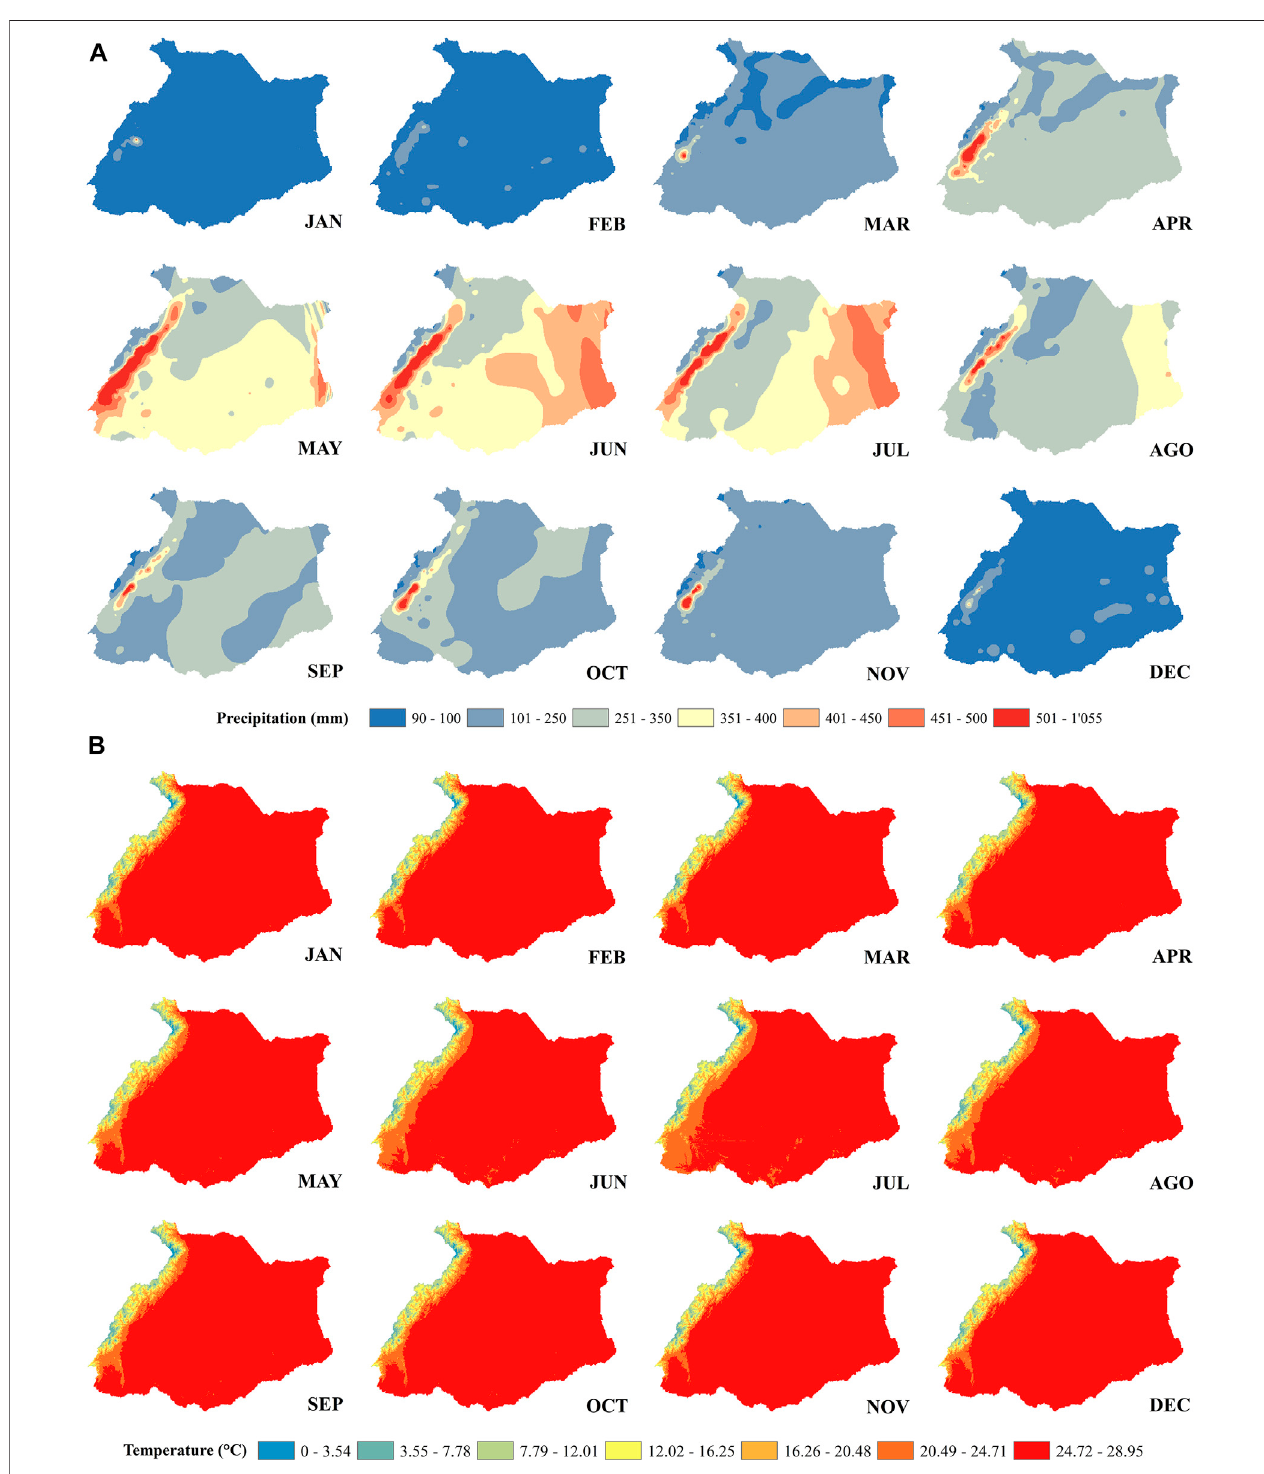
FIGURE 3 | (A) multi-year monthly total precipitation fi elds and (B) multi-year monthly mean temperature fi elds.